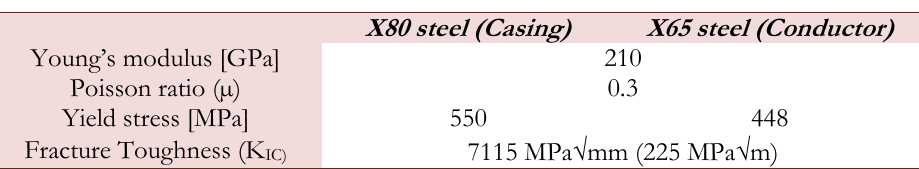
Table1: Material properties.